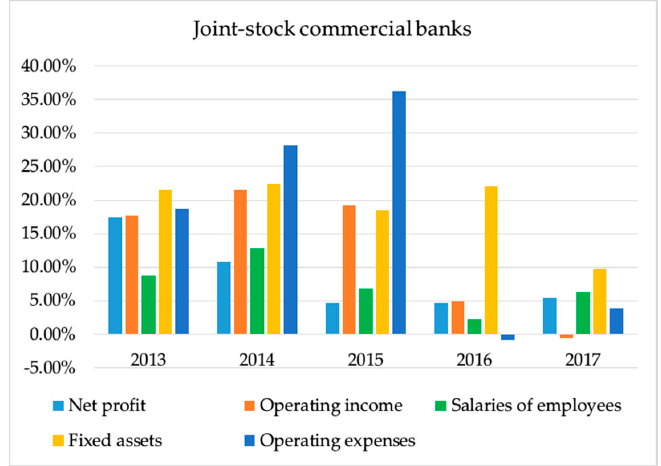
Figure 5. The trends of inputs and outputs (2012–2017).